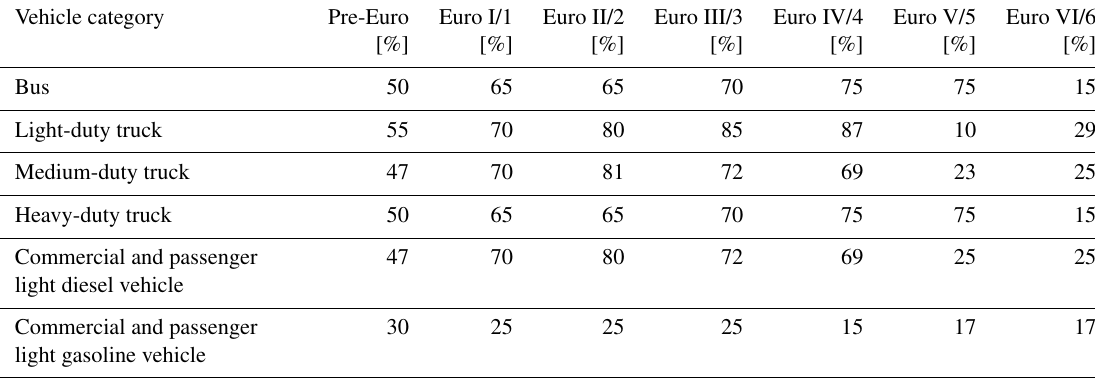
Table 4. BC / PM 2 . 5 fractions for vehicle emission technologies in Chile. Vehicle